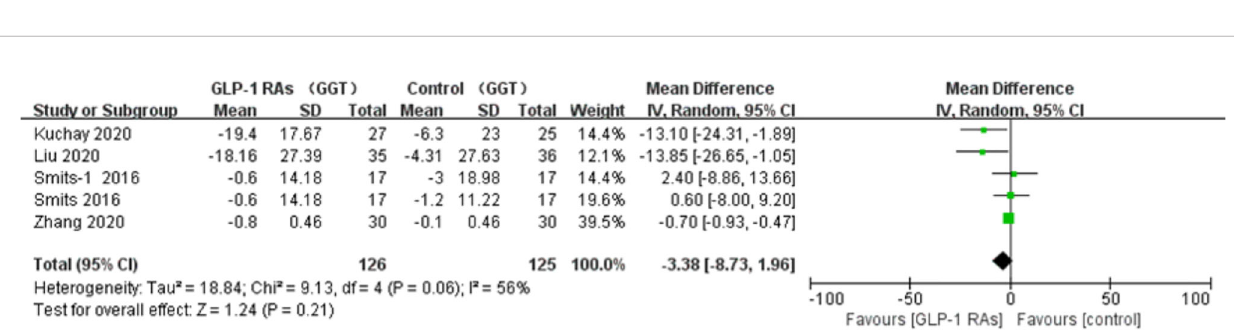
Frontiers in Endocrinology |